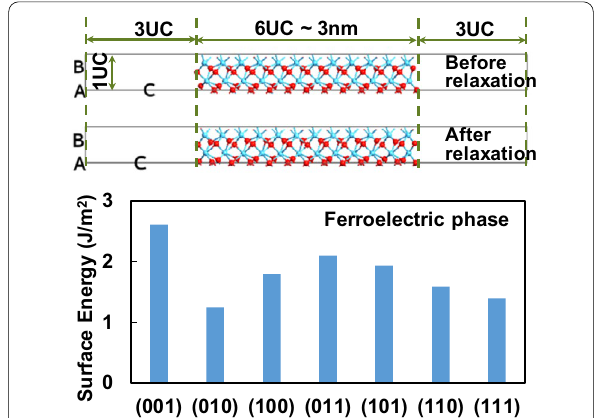
Fig. 8 Calculated surface energies of ferroelectric-HfO 2 slabs with different orientation